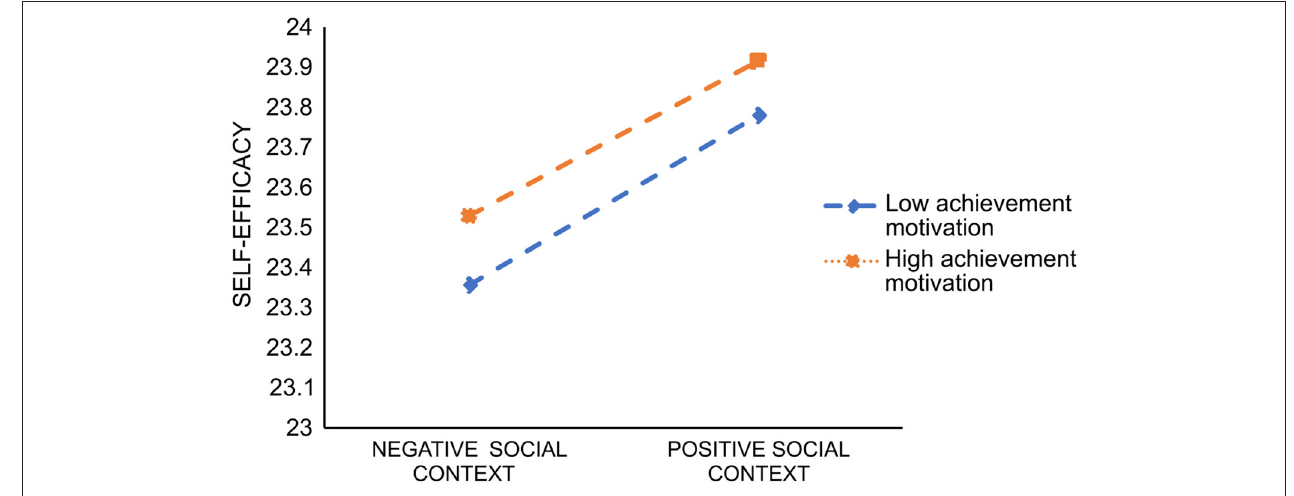
FIGURE 3 | Moderating effect diagram of achievement